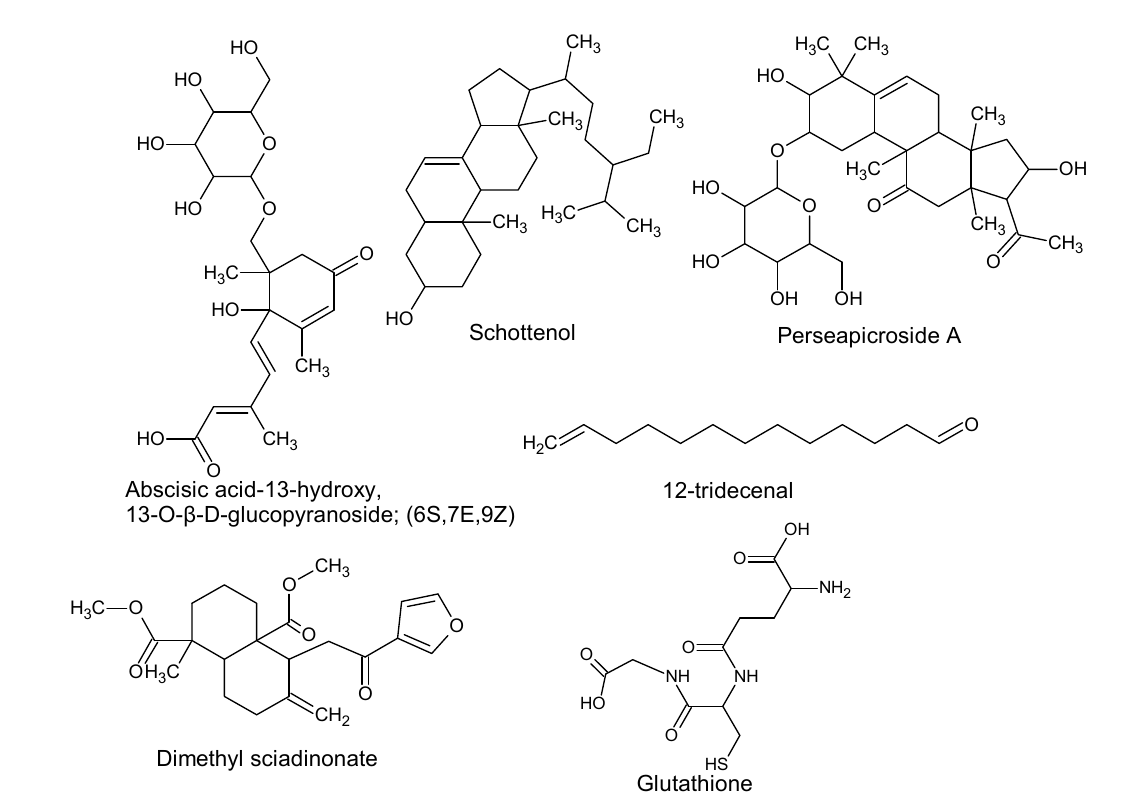
Figure 8. Miscellaneous compounds isolated from avocado.